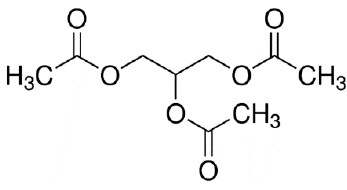
Figure 6. Structural formula of Triacetin.